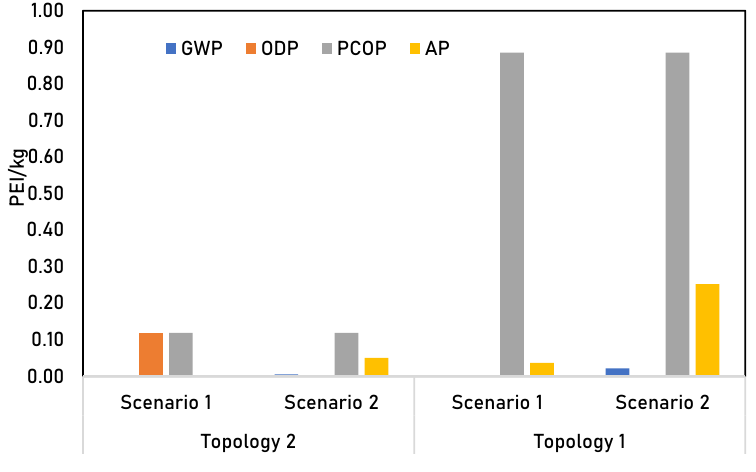
Figure 15. Output rates of PEI for atmospheric impacts.